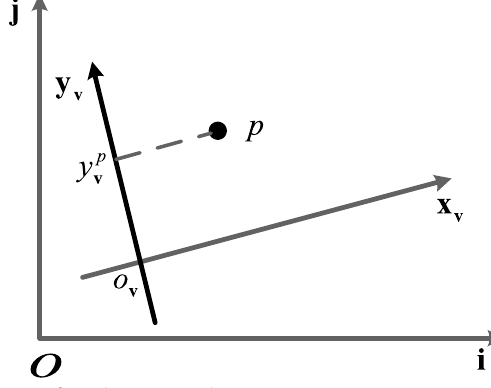
Fig. 1 The relative position of p with respect to the vector x